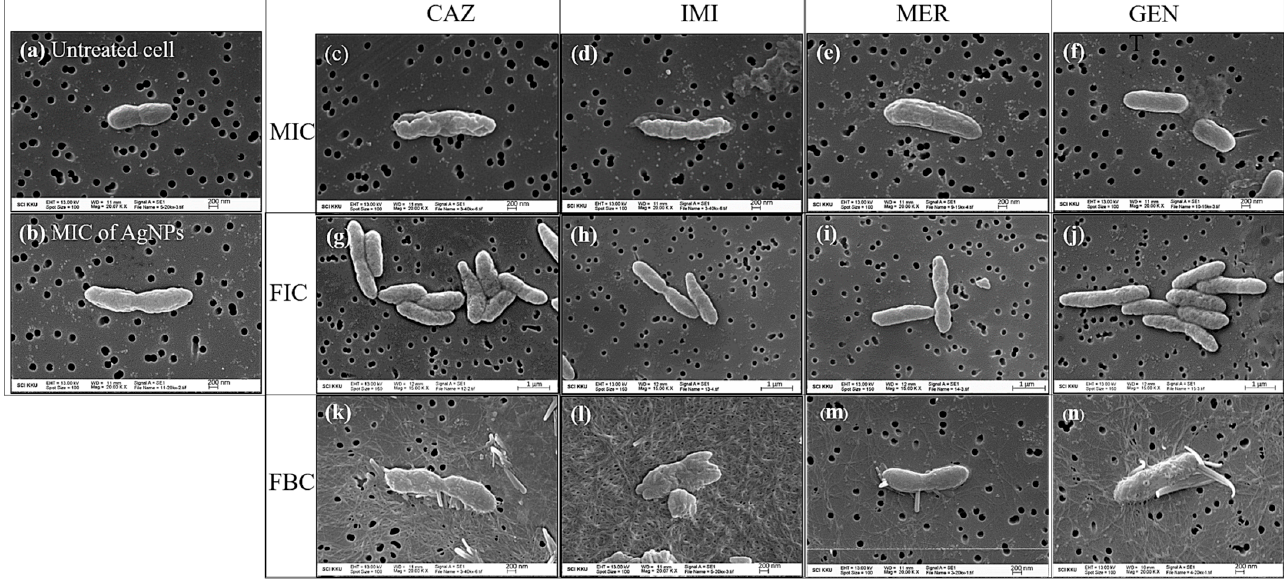
Figure 5. Scanning electron micrographs of B. pseudomallei 1026b: untreated ( a ) or treated with the MIC of AgNPs ( b ), CAZ ( c ), IMI ( d ), MER ( e ), or GENT ( f ). SEM images of 1026b treated with the FIC of AgNPs with CAZ ( g ), IMI ( h ), MER ( i ), or GENT ( j ) for 5 h. SEM images of 1026b treated with the FBC of AgNPs with CAZ ( k ), IMI ( l ), MER ( m );,or GENT ( n ) for 1 h.